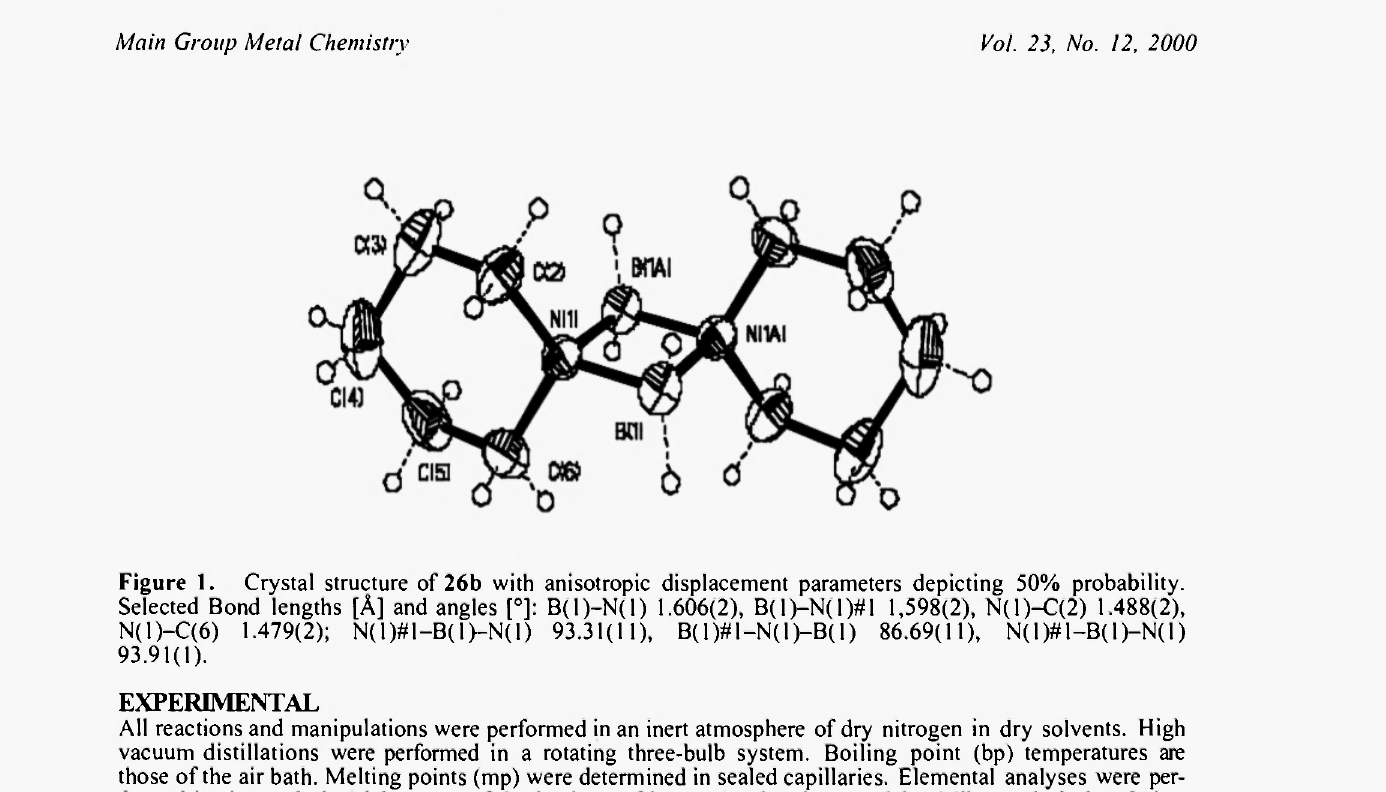
EXPERIMENTAL All reactions and manipulations were performed in an inert atmosphere of dry nitrogen in dry solvents. High vacuum distillations were performed in a rotating three-bulb system. Boiling point (bp) temperatures are those of the air bath. Melting points (mp) were determined in sealed capillaries. Elemental analyses were per- formed in the analytical laboratory of the institute of inorganic chemistry and by Mikroanalytisches Labor Beller, Göttingen, Germany. Preparative data of the compounds prepared according to the general preparation procedures given are compiled in the tables 2, 3 and 4. NMR-spectra were recorded on Bruker AM-250 or MSL-400 instruments in solutions of CDCl.i for compounds of types a and d and in C<,D 6 for all other moie- ties. Standards used were internal TMS (for 'H and 1 C) and external FiB ' OEt 2 for 1 B. Mass spectra were obtained on a Finnigan MAT 8230 (El, 70 eV) and a Varian CH5 instrument (field ionization, Fl). Synthesis and Preparation Data of Amino(dichloro)boranes (a), Aminoboranes (b), Amino- (chloro)boranes (c), Amino(dibromo)boranes (d), Bis(amino)chloroboranes (f), Bis(amino)bromoboranes (g), Bis(amino)boranes (h), Diborane-(6)-derivatives (i), (j), (k), Triborane-(9)-derivatives (s), Borane- amines (p). The Corresponding Aminogroups are: 25: 3-Methyl-piperidino-, 26: 2-Methyl-piperidino-, 27: 2-Ethyl- piperidino-, 28: 4-Methyl-piperidino-, 29: Piperidino-, 30: 3,5-Dimethyl-piperidino-, 31: 3,3-Dimethyl- piperidino-,